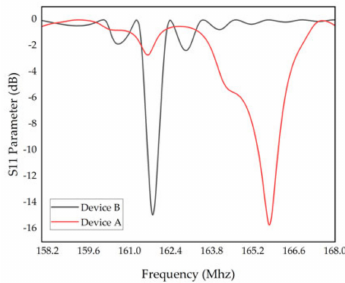
Figure 8. S11 curves of device A and B.